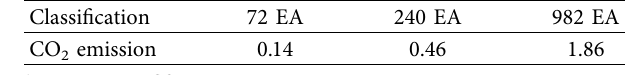
Table 5: CO 2 emissions of in-plant